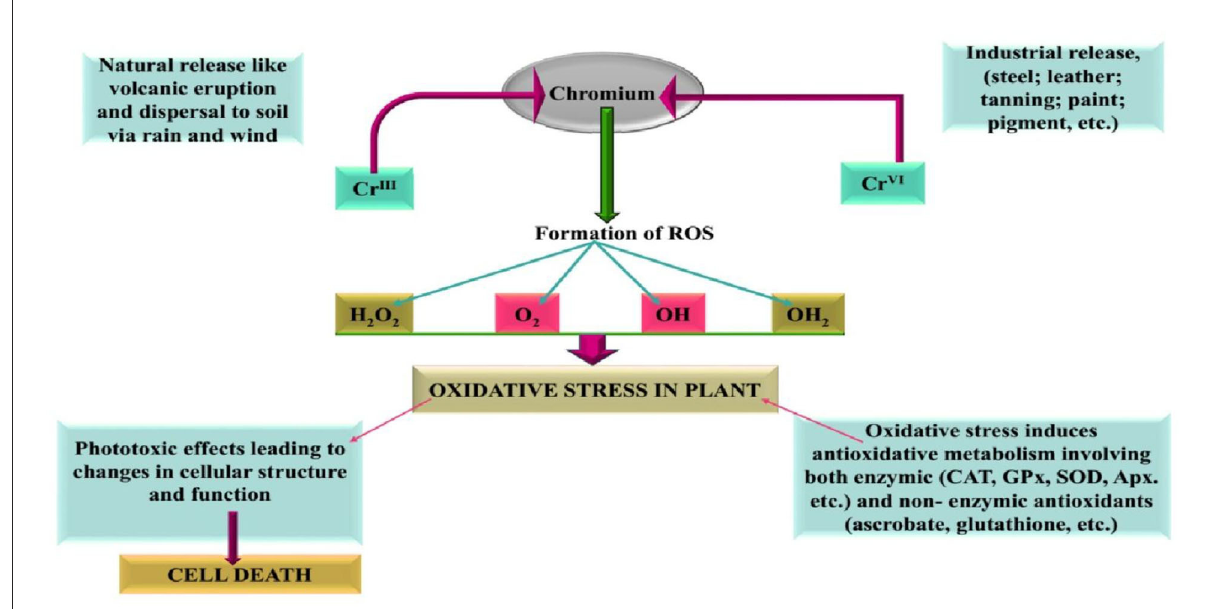
FIGURE1 Different sources of chromium and their involvement in including oxidative stress in plants (Panda and Choudhury,